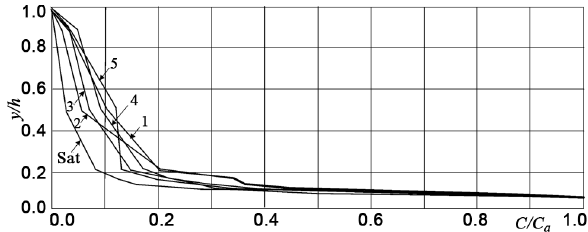
Fig. 4. Vertical sediment distribution according to Cellino (1999) investigations measured by taking water samples during runs 1–5 and also in saturated flow. h – water depth, y – dis- tance from the bottom, C a – sediment concentration at the depth y = 0.05